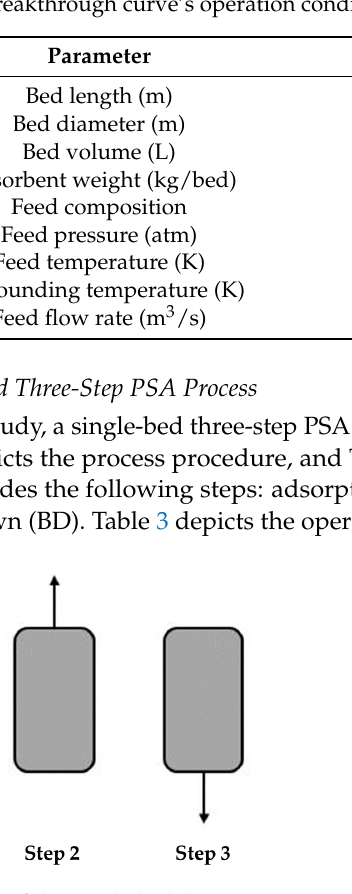
Table 1. The breakthrough curve’s operation conditions.